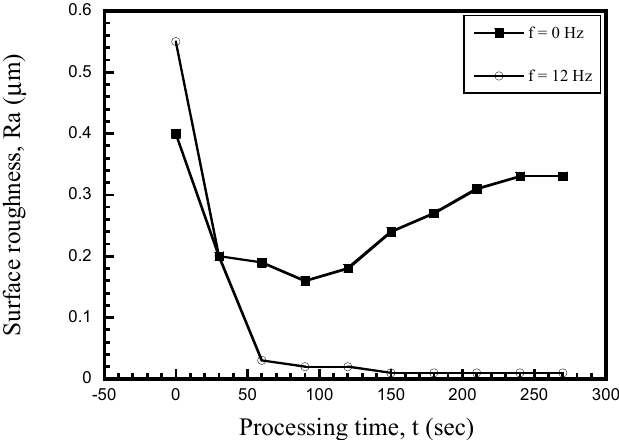
Figure 8. Variations of surface roughness ( R a) against processing time. (spindle revolution speed: 30,000 rpm, diamond paste weight: 200 mg, diamond paste grain size: 1 µm).